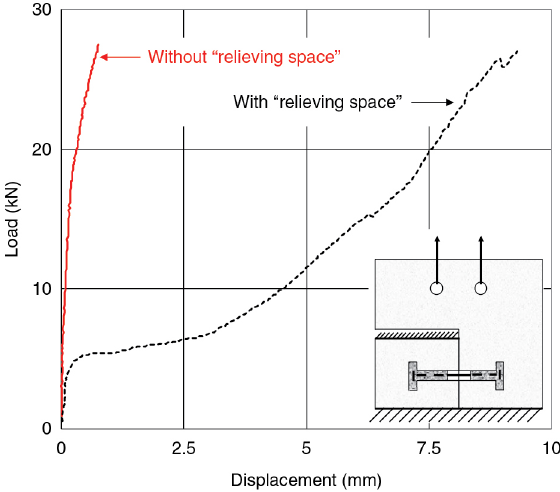
Figure 2: Experimental results for the load-displacement relation for mutually interconnected epistyles under pure shear loading. The displacement was determined using the 3D-DIC technique. Results for specimens with and without a reliev- ing space are shown